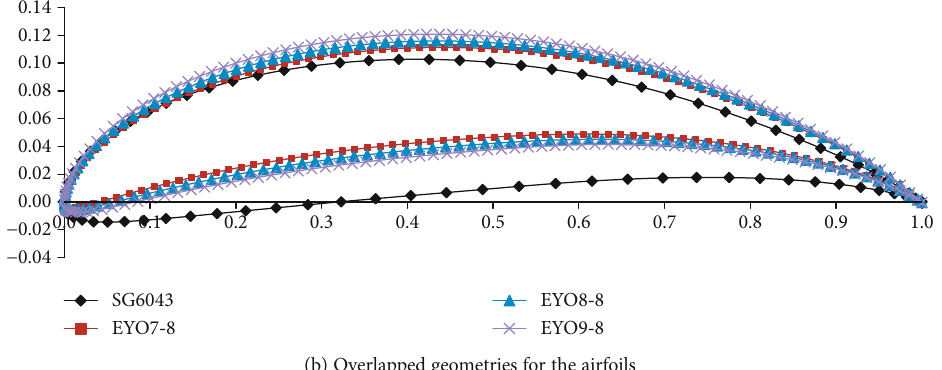
Figure 3: Geometries of base and new EYO-Series airfoils (in dimensionless